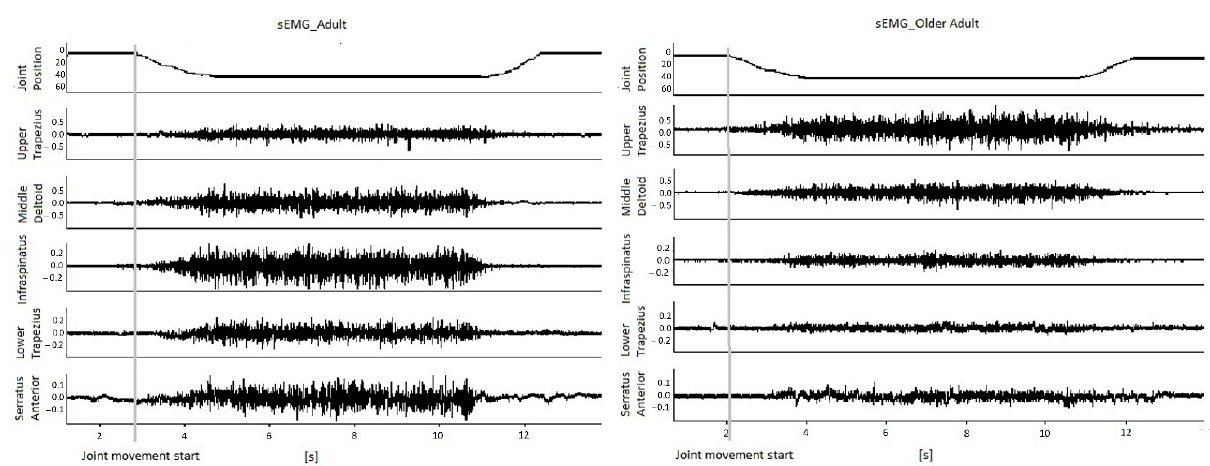
Figure 1. Raw surface electromyography (sEMG) recordings of the five muscles (indicated on the left ) simultaneously displaying the abduction movement (from 0° to 45°). These have been obtained from one representative participant from the Older Adults group and one from the Adults groups, displaying the abduction movement.